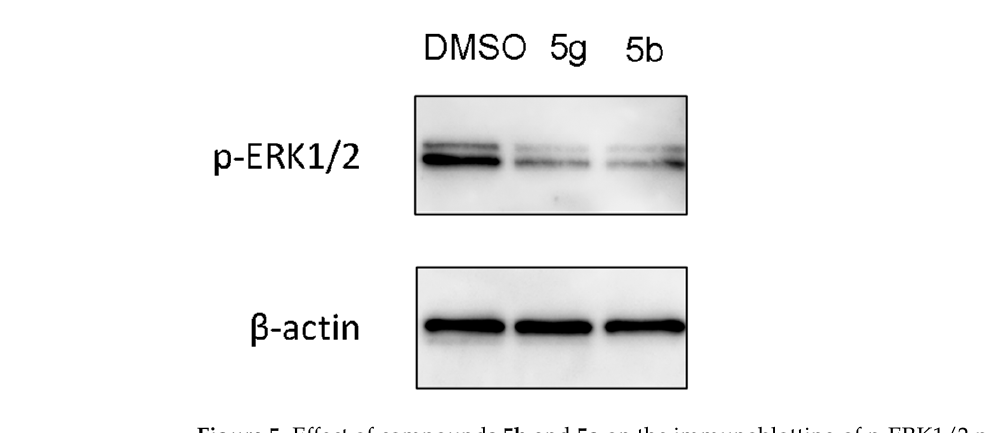
8 of 18 Figure 4. Cell cycle analysis of the HL60 cells treated with compound 5b and 5g for 24 h using flow cytometry. 3.2.4. Western Blot Analysis To explore the mechanism of action of the synthesized compounds and the most probable target inside the cells, we used the Swiss target prediction tool [42]. Swiss target prediction tool showed that ERK1/2 are among the most probable targets of the synthe- sized compounds. The extracellular signal-related kinases 1 and 2 (ERK1/2) are ser- ine/threonine kinases that play a key role in signal transduction of growth factors. ERK1/2 are the terminal kinases in the RAS-RAF-MEK-ERK signaling cascade (MAPK pathway), which is crucial for signal transduction from cell surface receptors to transcription factors inside the nucleus and regulation of gene expression inside cells. Stimulation of receptor tyrosine kinase (RTK) by mitogens, growth factors and cytokines recruit and activate RAS, which in turn activates the Raf family (A-Raf, B-Raf and C-Raf). Active Raf phosphorylates and activates the dual-specificity kinases, MEK1 and its homologue MEK2 (MEK1/2), which sequentially phosphorylate the serine/threonine kinases ERK1/2 [43]. Phosphory- lated ERK1/2 (P-ERK1/2) catalyze and phosphorylate 250 cytosolic and nuclear down- stream substrates including transcription factors (e.g., Ets-1, Elk-1, c-Fos, c-Jun), and the RSK family of kinases, phosphatases, apoptotic proteins, and cytoskeletal proteins, among many others. This wide array of substrates regulates many cellular functions, such as gene transcription, cell cycle progression, proliferation, migration, adhesion, survival and me- tabolism [44]. Furthermore, the importance of ERK1/2 for the transition of cells from G1 to S phase in the cell cycle, and its ability to inhibit cell apoptosis through inhibition and phosphorylation of caspase 9 was reported [45]. In a particular relevance to oncology, mutations in RAS or RAF result in activation of the RAS-RAF-MEK-ERK signaling cascade (MAPK pathway) in over 30% of cancers including melanoma, lung, pancreatic, colorectal (CRC) cancer and acute myeloid leuke- mia (AML) [46,47]. There are approved drugs on the market which act through inhibition of BRAF and MEK1/2 kinases, however their therapeutic benefits are limited by resistance resulting from BRAF amplification or MEK mutation which reinstate ERK activity. Pres- ence of ERK1/2 in the distal end of the RAS-RAF-MEK-ERK pathway, and because it is rarely undergone mutations, make ERK1/2 an attractive target for the development of an- ticancer drugs. Currently, the design and synthesis of compounds with antitumor activity through targeting ERK1/2 have increased and some of them entered clinical trials, but no drug has been approved to date [43,48]. Based on the results of molecular target prediction using the Swiss target prediction tool, we measured the effect of the most active compounds 5b and 5g on phosphorylation of ERK1/2 in HL-60 cells. Where, HL-60 cells were incubated with compounds 5b and 5g for 24h, then levels of phosphorylated ERK1/2 (p-ERK1/2) were evaluated using Western blot analysis. The results, depicted in Figure 5, explore how the target compounds signif-